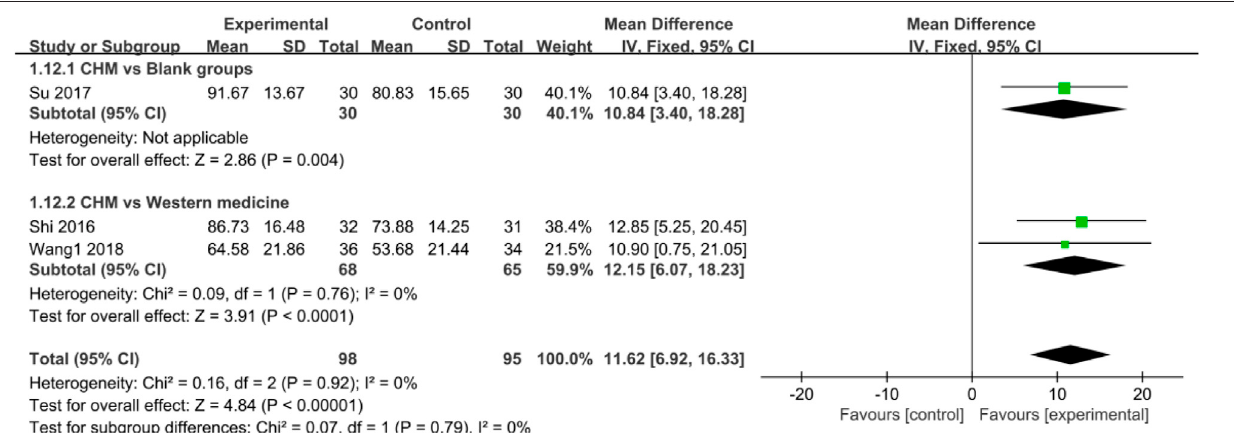
FIGURE 8 | Forest plot: CHM for improved AS in CHD with depression compared with control groups.